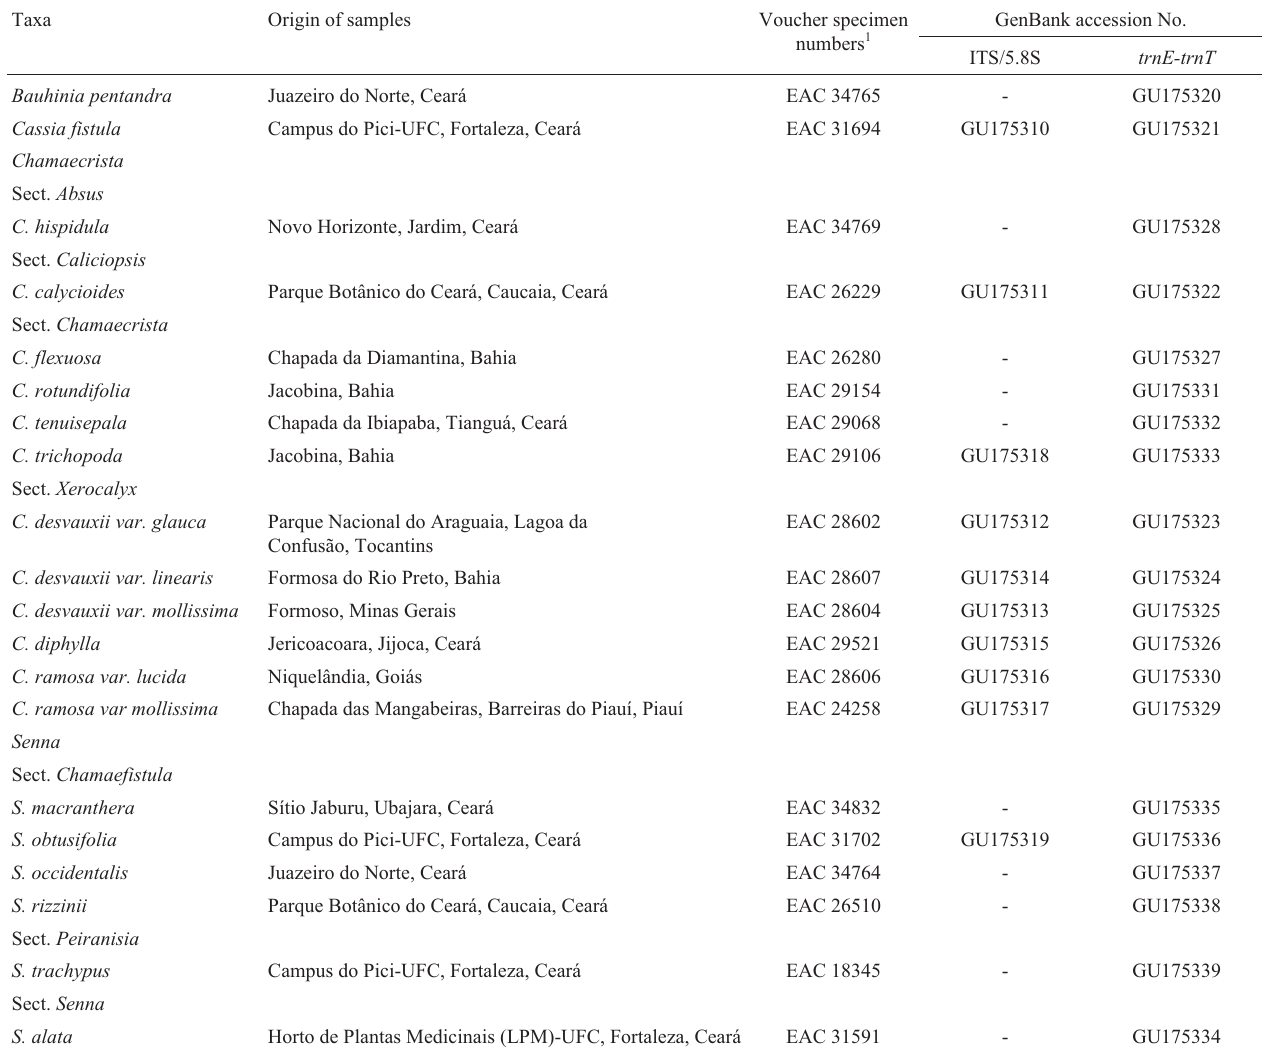
Table 1 - List of taxa (subtribe Cassiinae and outgroups) included in the phylogenetic